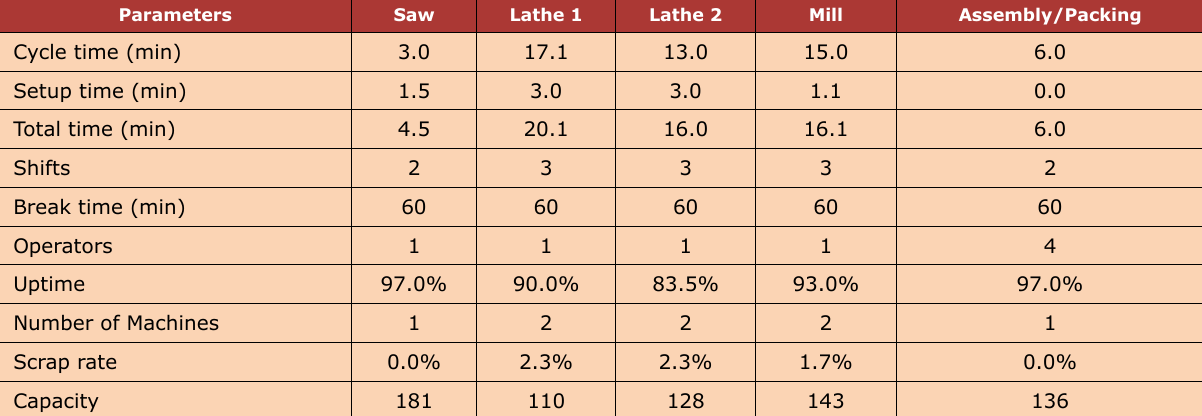
Table 3. Capacity analysis of one old one new Mills